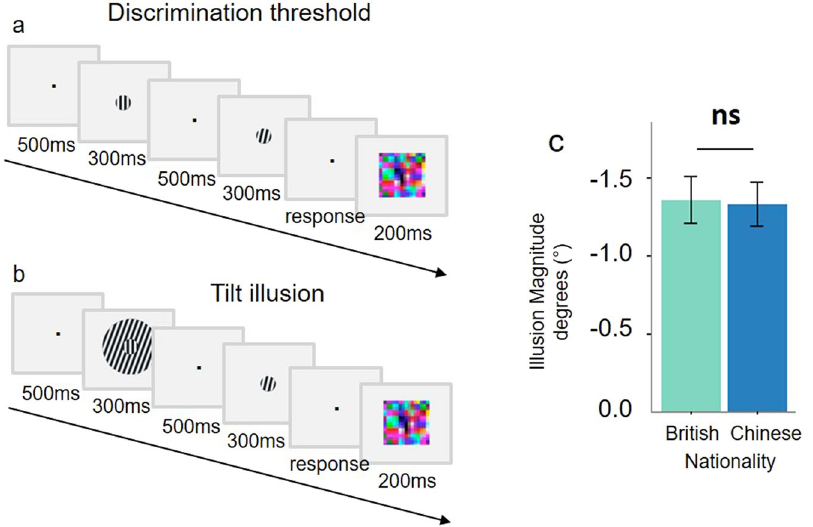
Figure 3. Tilt illusion task and results. ( a ) Shows an example trial from the staircase procedure which first measured orientation discrimination threshold. Participants indicated whether the stimulus in the second interval appeared clockwise or anti-clockwise relative to the stimulus in the first interval. ( b ) Shows a trial in the two alternative forced choice measurement of the tilt illusion magnitude. On each trial, participants indicated whether the central stimulus in the second interval, compared with the central stimulus in the first interval, appeared clockwise or anti-clockwise. ( c ) The tilt illusion magnitude did not differ between cultures. Error bars show